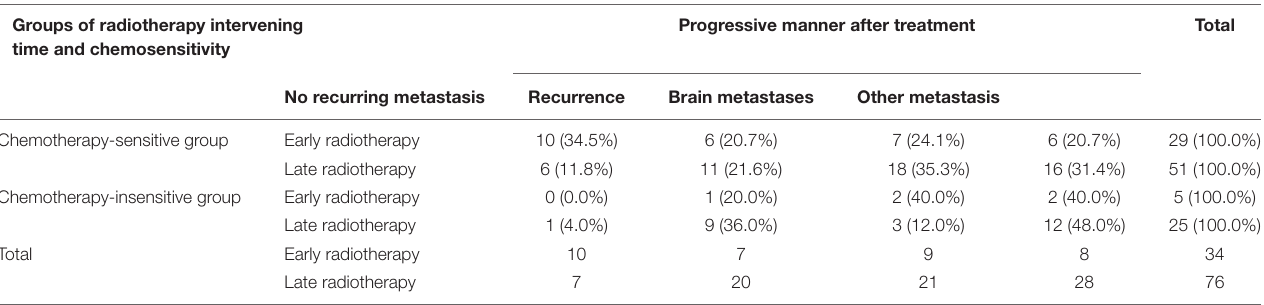
TABLE 3 | Relation between chemosensitivity and progressive manner of different radiotherapy intervening groups. Groups of radiotherapy intervening time and